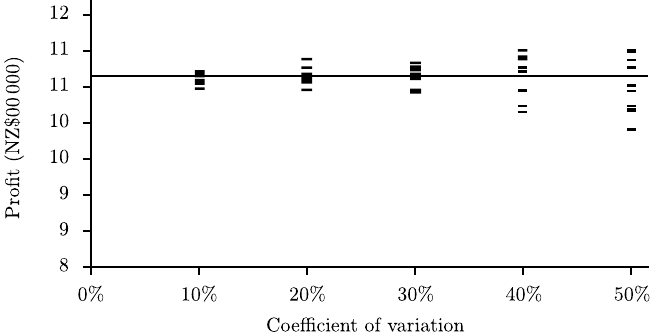
Figure 5: Fluctuation in the profit due to variability in catch rate and fixed trawler scheduling of